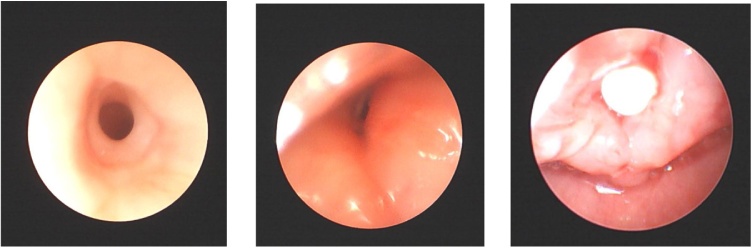
Images – Tracheal Bronchoscopy.